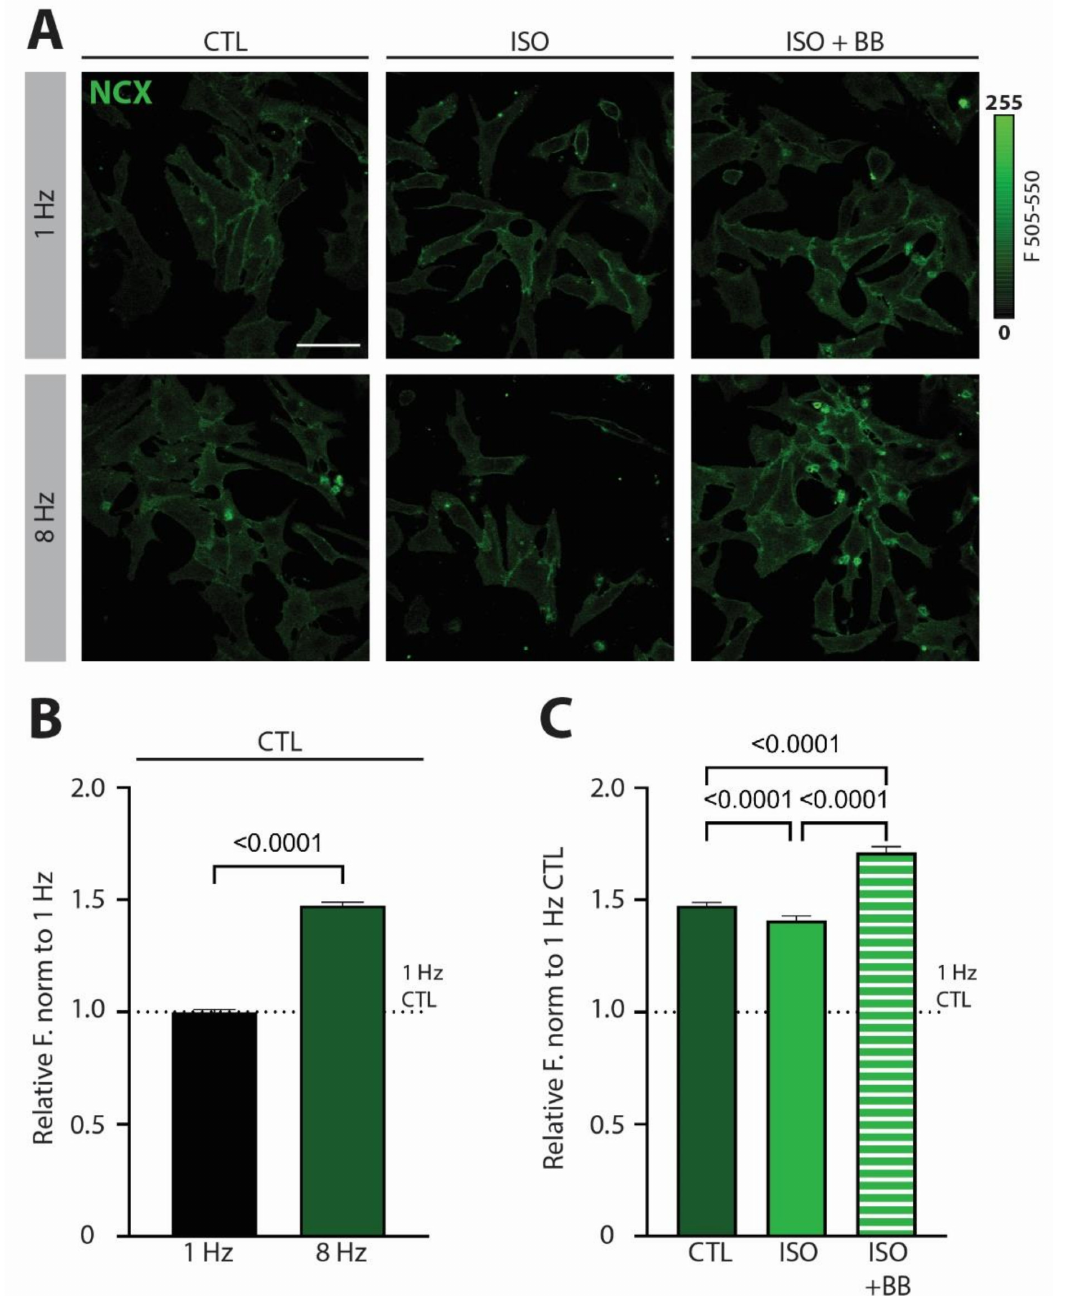
Figure 1. β -adrenergic signaling prevents NCX upregulation under increased workload in neona- tal rat ventricular cardiomyocytes (NRVCMs) . ( A ) Representative fluorescent images of NRVCMs immunostained against NCX exposed to 3 h of low pacing (1 Hz) or tachycardic pacing (8 Hz) frequency under control conditions (CTL), β -adrenergic stimulation with isoprenaline (ISO) or β -adrenergic stimulation following 1 h preincubation with β -blocker propranolol (ISO + BB). Scale bar indicates 50 µ m. ( B ) Mean fluorescent values of CTL under low pacing frequency (1 Hz) or tachycardia (8 Hz) normalized to the 1Hz condition. ( C ) Mean fluorescent values of CTL, ISO and ISO + BB at 8 Hz normalized to the CTL at 1 Hz. Data are shown as mean ± SEM ( n = 760–1171 cells from N = 4 isolations). Indicated p -values were calculated using ( B ) Mann–Whitney test comparing 8 Hz to 1 Hz under CTL conditions or ( C ) Kruskal–Wallis test comparing normalized CTL, ISO or ISO + BB levels at 8